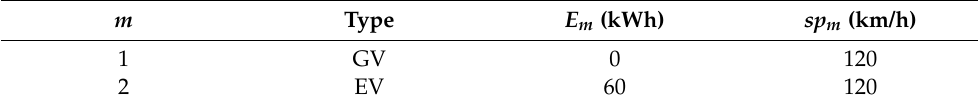
Table 4. Attributes of the vehicle